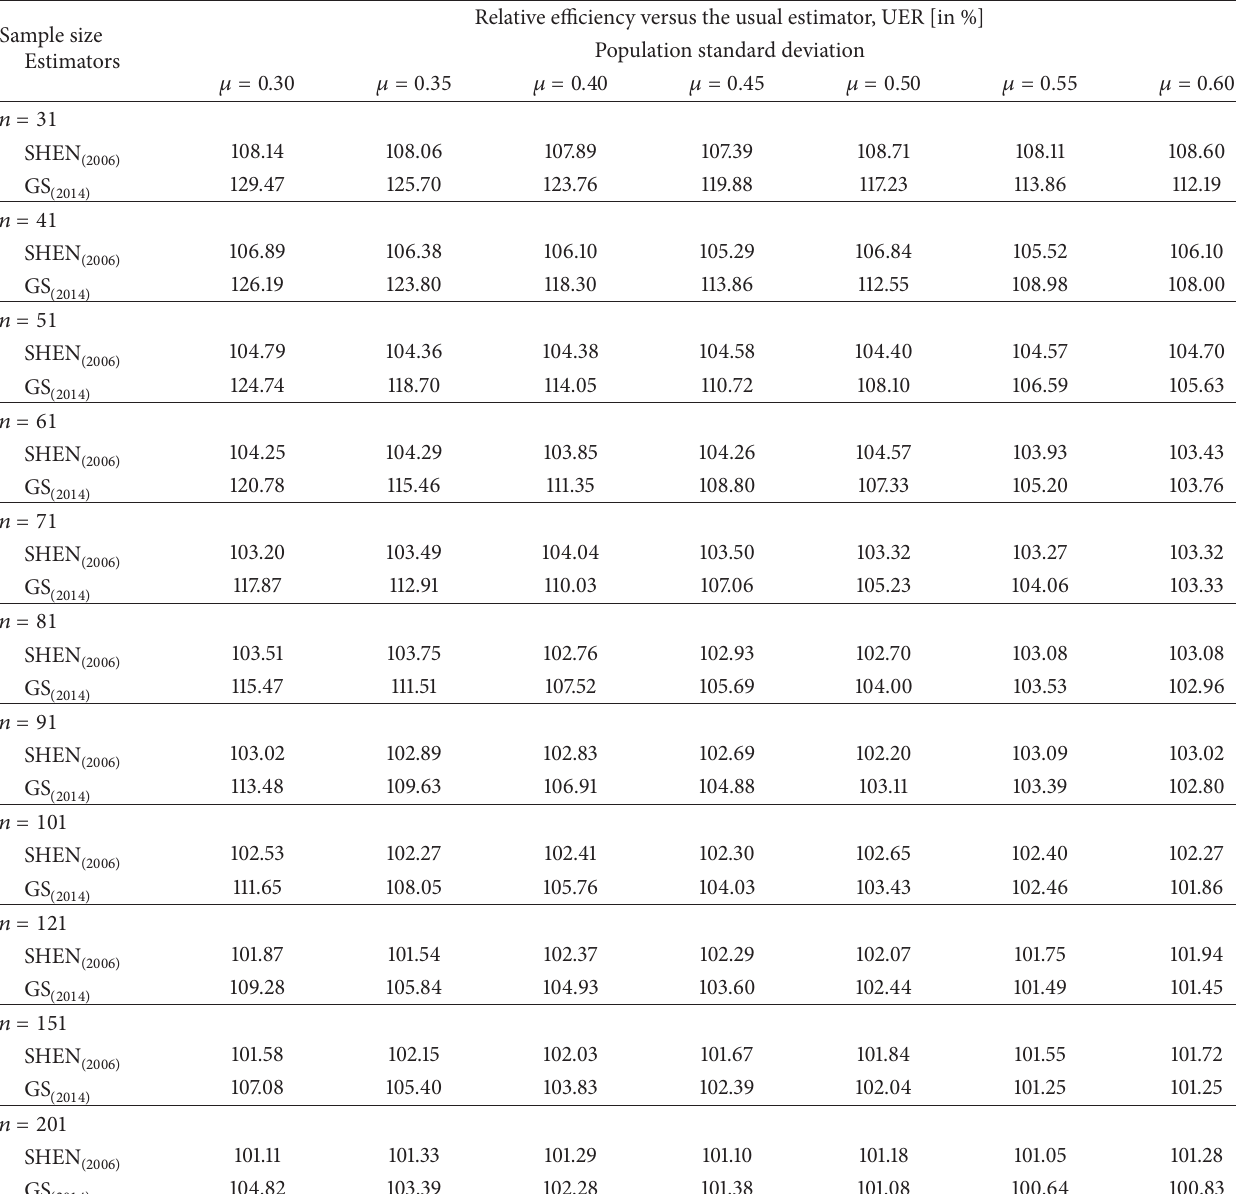
and GS estimators across varying sample sizes and population standard deviations. (2006) (2014)